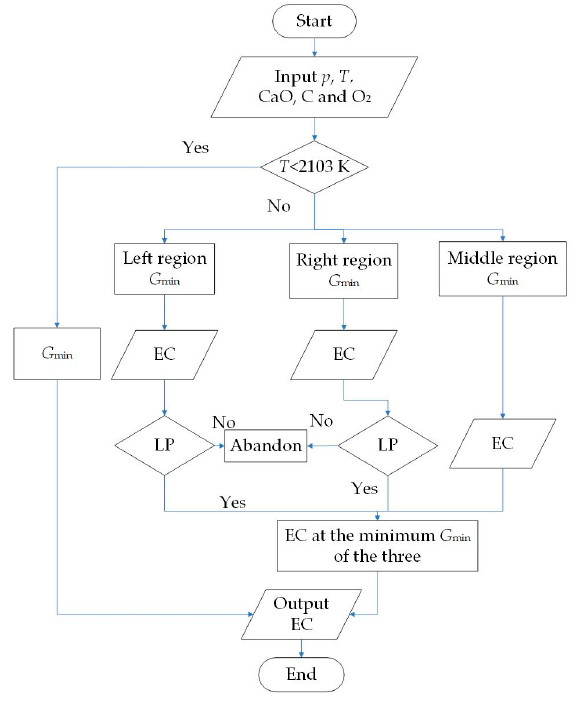
Figure 11. Calculation flow diagrams of the equilibrium components.